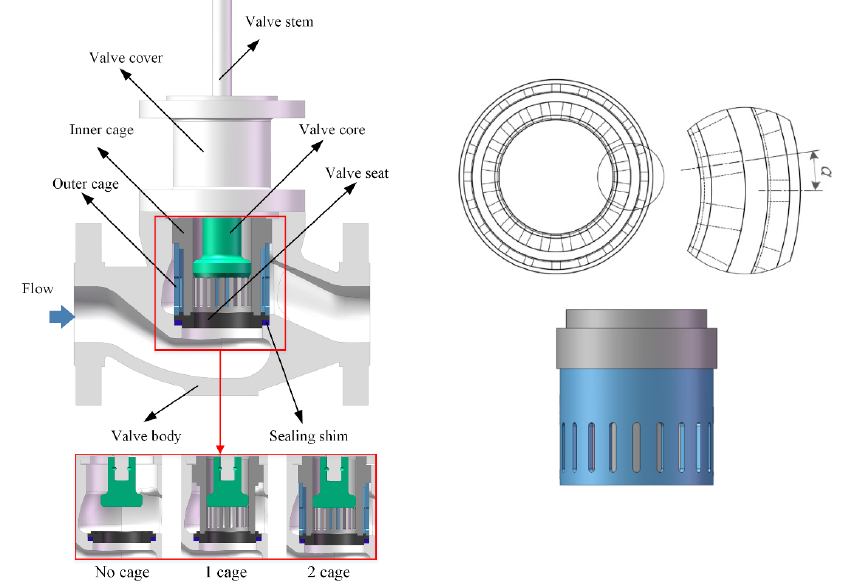
Figure 2. Structure of the investigated globe valve.